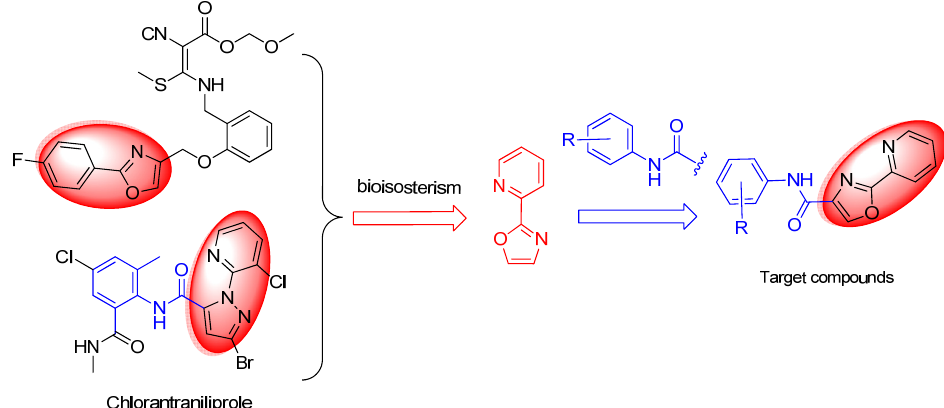
Figure 3. Design strategy of target compounds.